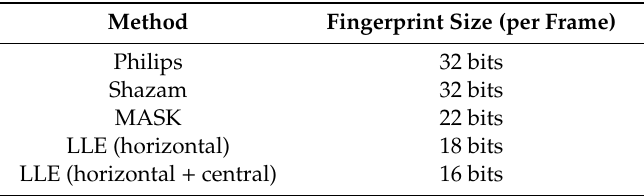
Table 7. Fingerprint size of di ff erent methods.